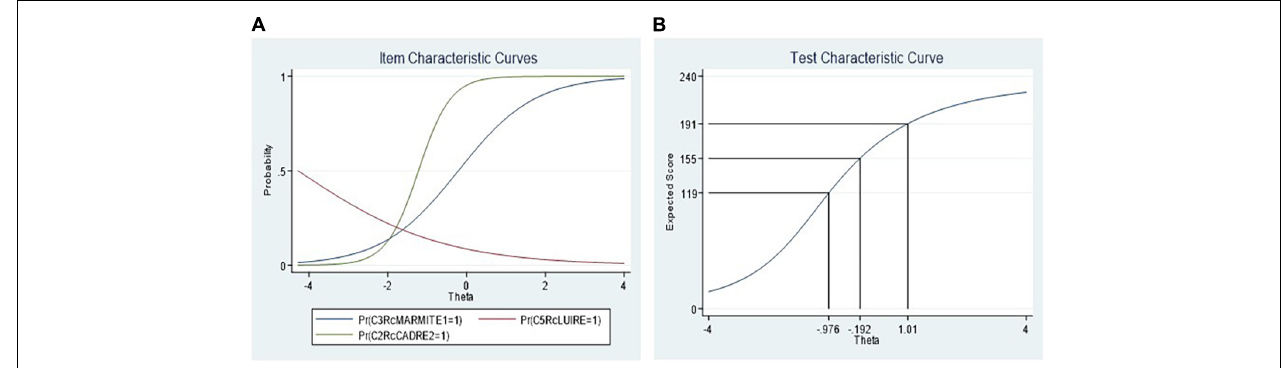
FIGURE 3 | (A) icc for three contrasted items as a function of their discrimination coefficients, indicating the lowest ( α = -0.55; luire ; shine), the highest ( α = 2.45; cadre ; frame) and a mean coefficient discrimination ( α = 1.03; marmite ; pot); (B) tcc with three expected scores (mean score (m = 155), m-sd = 119), and m + sd = 191) and the corresponding latent trait scores ( N = 281). Notes : icc, item characteristic curves; tcc, test characteristic curve; m, mean; sd, standard deviation.